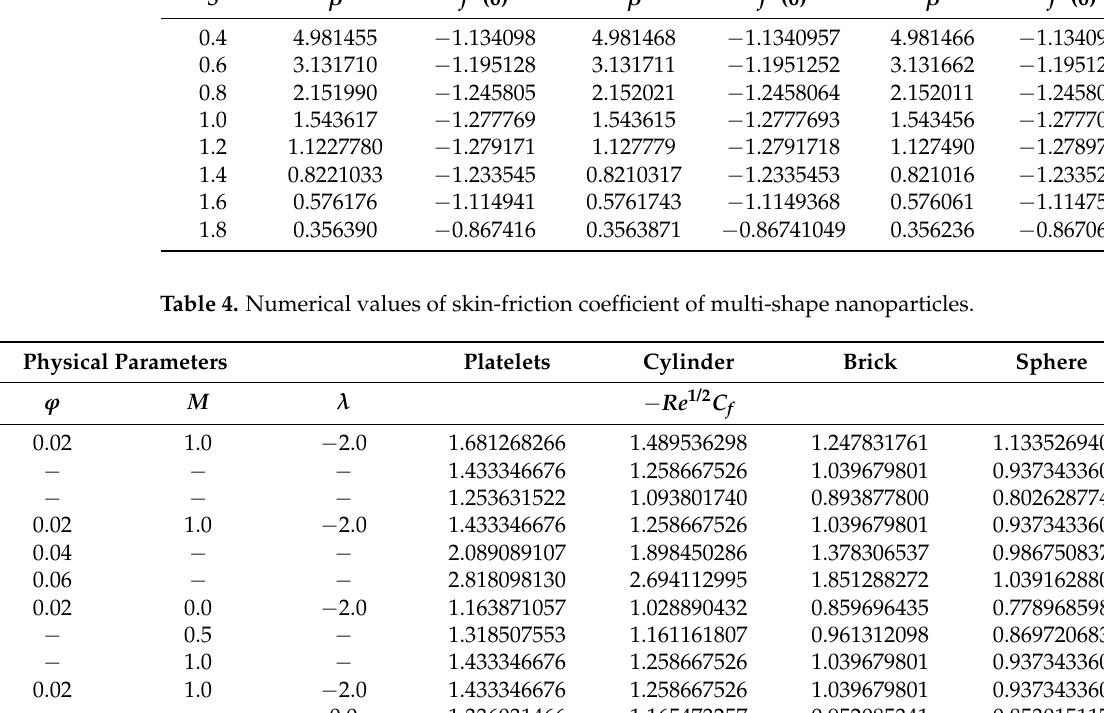
Table 3. Comparison of numerical results when M = K = ϕ = 0. Abel et al. [54] Ali et al. [45]